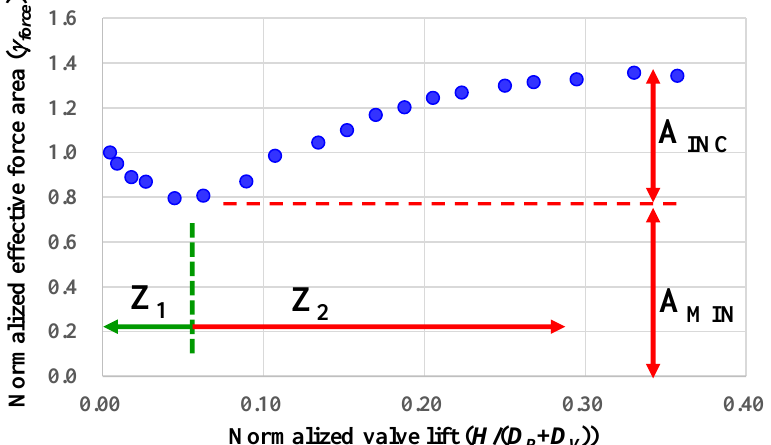
Figure 7. Normalized effective force area for various values of valve lift ( R P = 2.2 mm, R V = 3.4 mm, and ∆ P = 1.0 kPa).